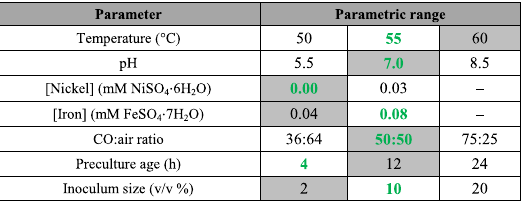
Values shaded in grey represent those used in previous experiments (Mohr et al., 2018a, b). Values in bold and green represent those which gave highest H 2 productivity and/or H 2